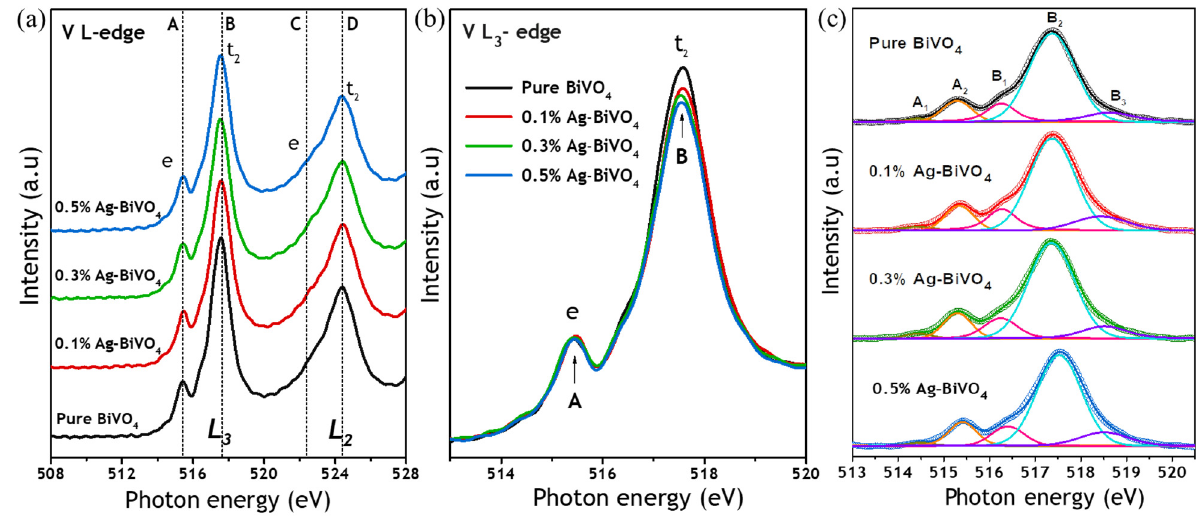
Figure 5. ( a ) V L-edge XAS spectra of pure BiVO 4 and Ag–BiVO 4 . ( b ) Magnified view of the V L 3 -edge XAS spectra. ( c ) The resultant fit to the V L 3 -edge XAS spectra of the samples.